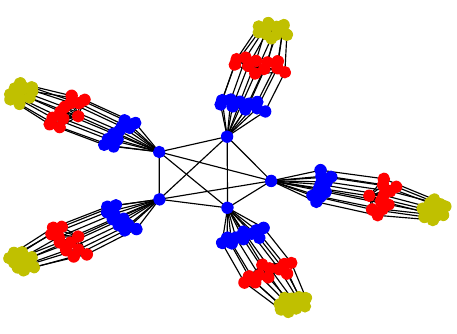
Figure 11. Network of Structure 2.